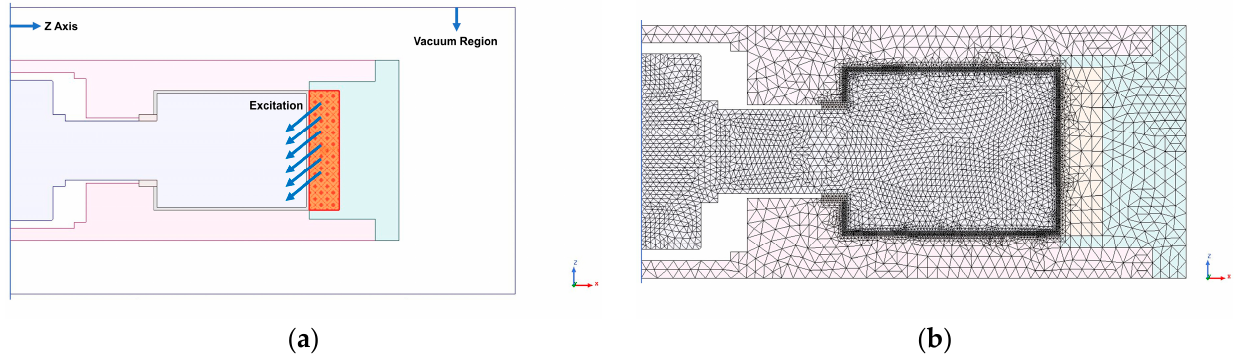
Figure 6. Magnetic field analysis simulation setup of axial single-coil configuration: ( a ) excitation and boundary settings; ( b ) finite element meshing.